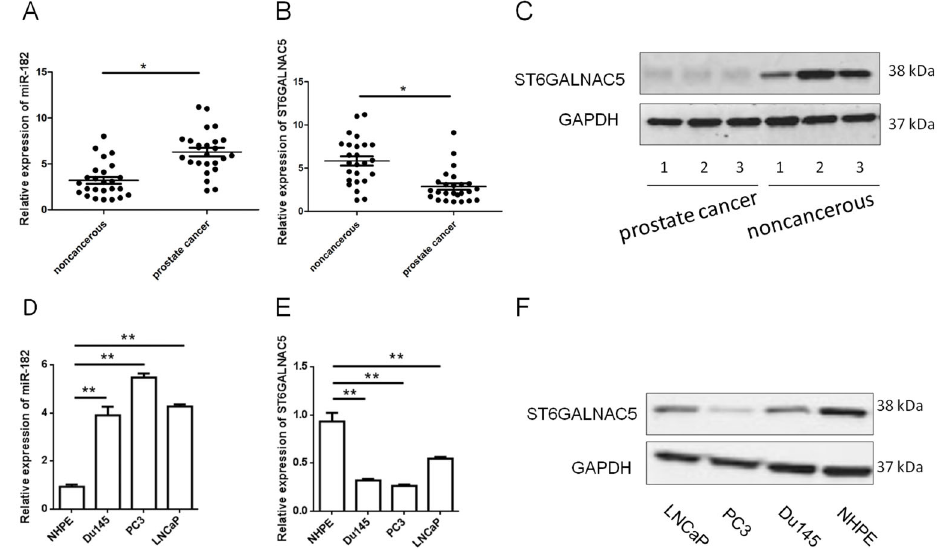
Figure 1. A , Expression of miR-182 in 25 pairs of prostate cancer (PCa) tissue and adjacent noncancerous tissue samples were analyzed by qRT-PCR. B and C , ST6GALNAC5 in tissues was also determined by qRT-PCR and western blot. D , Expressions of miR-182 and ( E and F ) ST6GALNAC5 in PCa cell lines were analyzed by qRT-PCR. Data are reported as means ± SD. *P o 0.05; **P o 0.01 (paired t -test and one-way ANOVA).